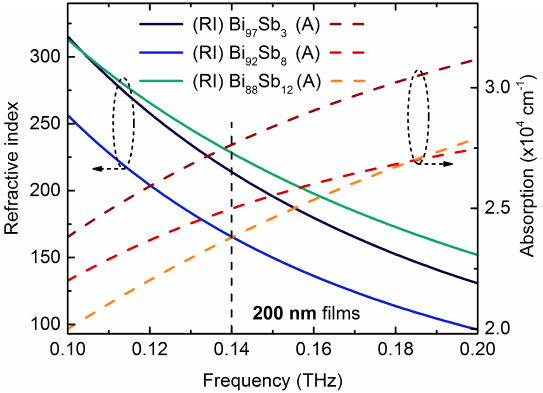
Figure 4. Refractive index (solid lines) and absorption coefficient (dashed lines) dispersions of 200 nm Bi 1 − x Sb x films in 0.1–0.2 THz frequency range for various Sb concentrations [17]. The vertical line at 0.14 THz represents the frequency point for parameters values used in further calculations.